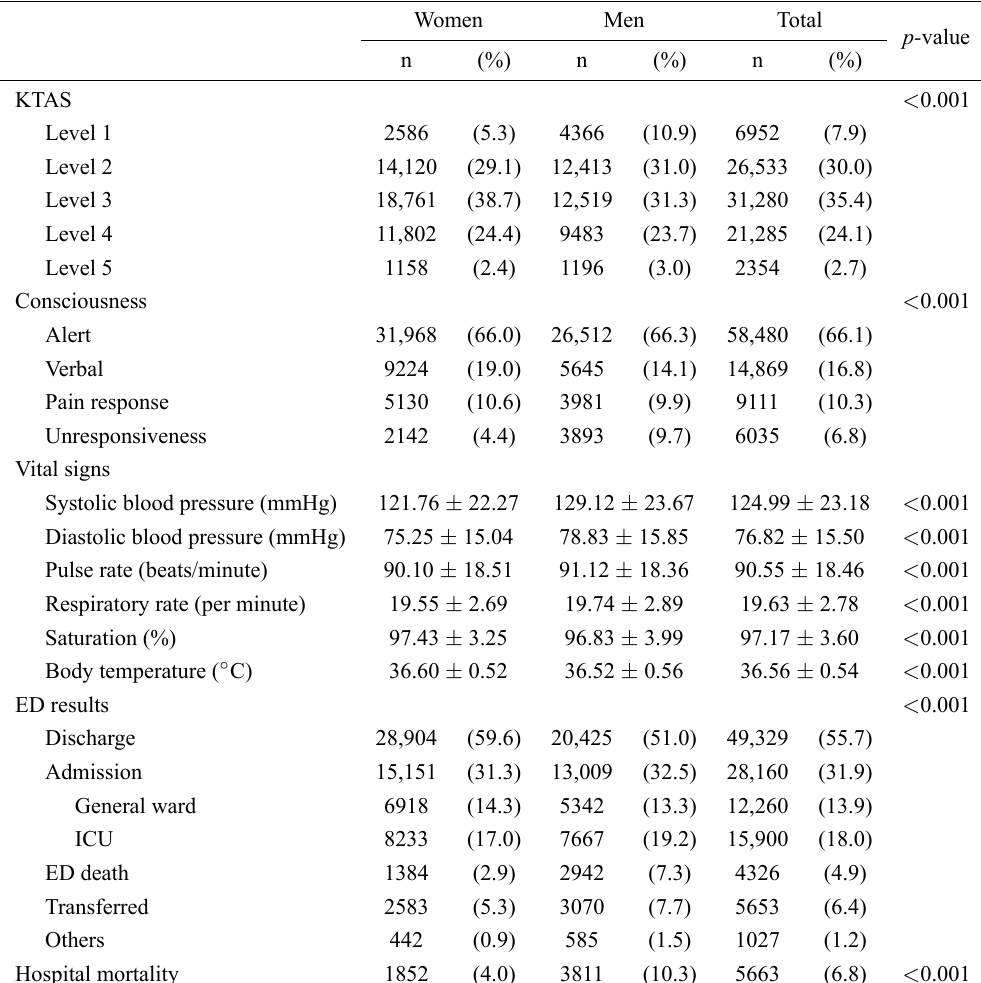
Table 2. Comparison of clinical characteristics and outcomes between women and men who visited EDs with deliberate self-harm.